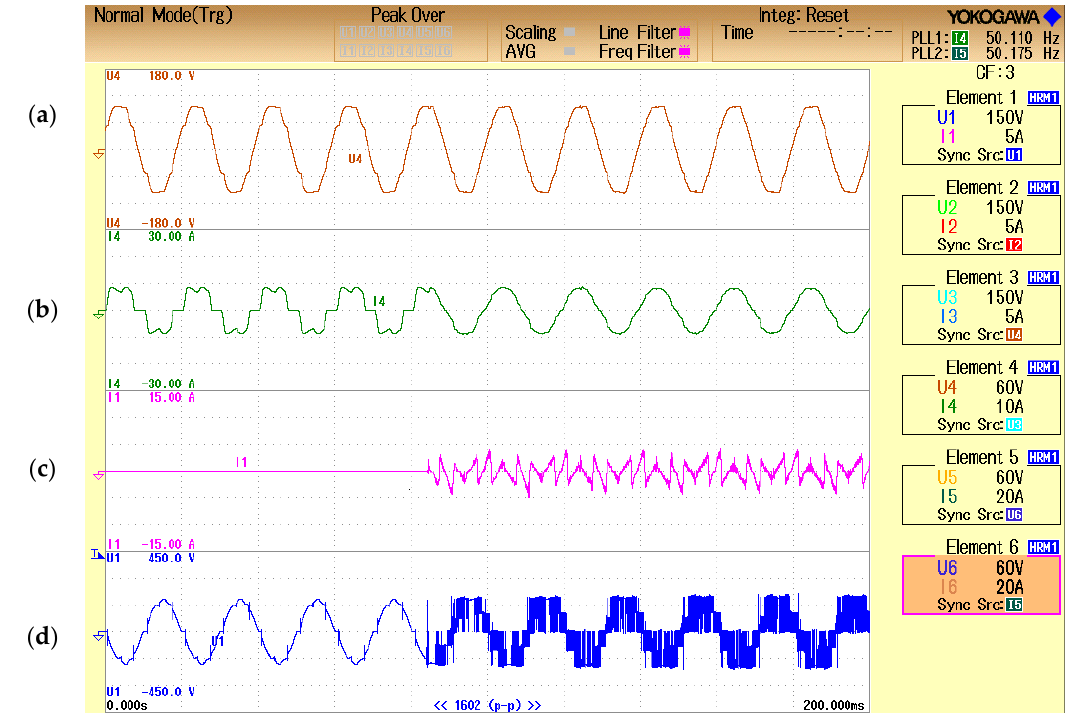
Figure 15. Single phase: ( a ) supply voltage; ( b ) supply current; ( c ) compensator current; ( d ) compensator voltage. The load currents of the three phases are shown in Figure 16, which are purely non- sinusoidal, as load current is non-linear by nature. The three source currents are shown in Figure 17, and are purely sinusoidal.